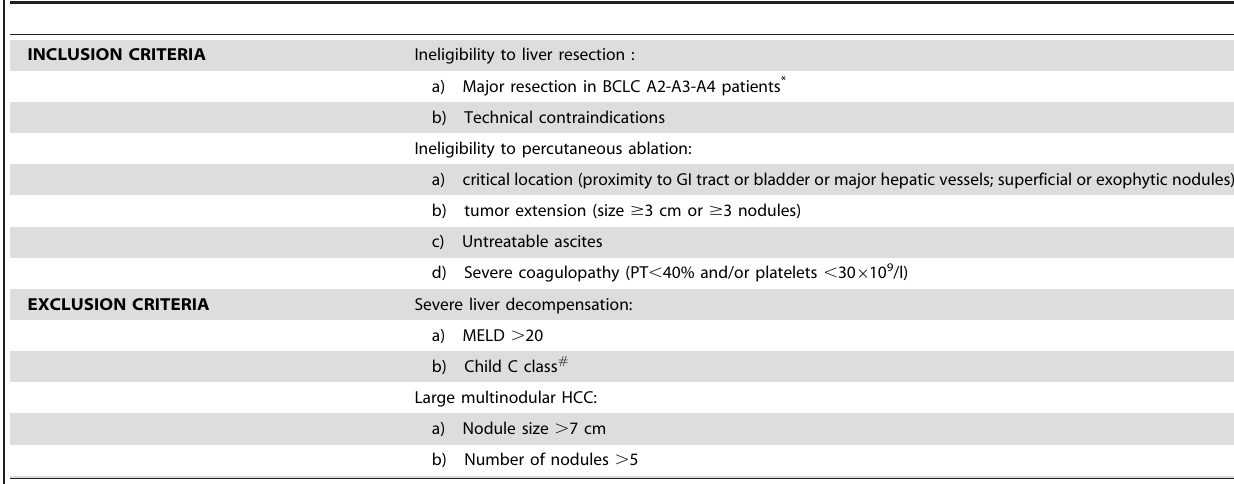
Table 1. Selection criteria for laparoscopic ablation of HCC patients at the Padua University